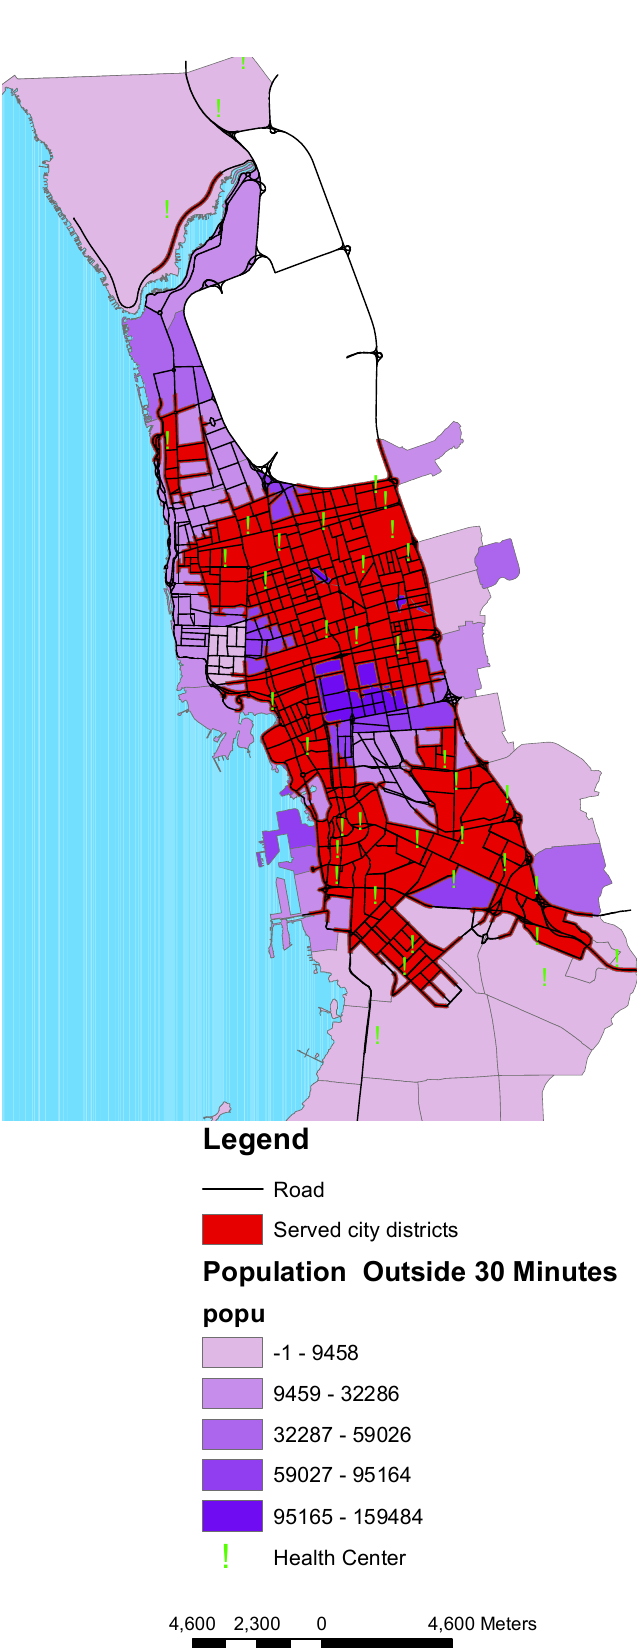
Figure 5. Population unserved by health centers.